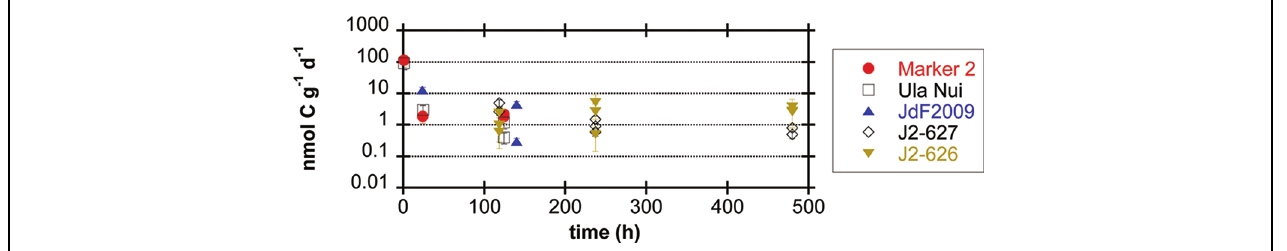
FIGURE 3 | Potential rates of carbon fixation by seafloor-exposed basalt-hosted microbial communities (expressed as nmol C incorporated g − 1 rock d − 1 ) as a function of incubation time, based on incubation experiments of basalt samples with 13 C-labeled bicarbonate. Error bars represent the range of the coefficient of variance from the measurement of organic carbon weight percent, since the mean value for each sample set was applied to all samples in that set (see Materials and Methods); in some cases, data symbol is larger than the error bar range. Samples with isotopic composition differences of less than 2 (cid:2) from the time zero sample ( Table 3 ) were assumed to be below the limit of detection of the method (see Materials and Methods) and are not reported